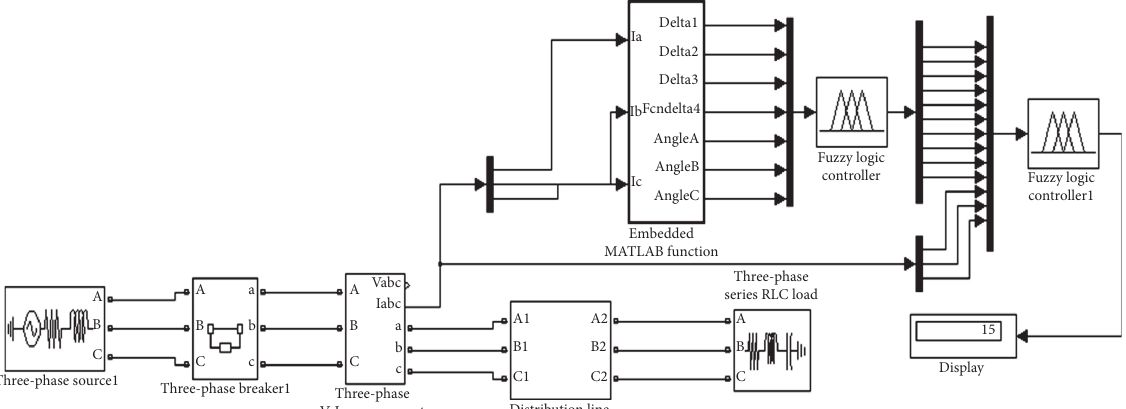
Figure 5: Simulink model for the fuzzy inference system